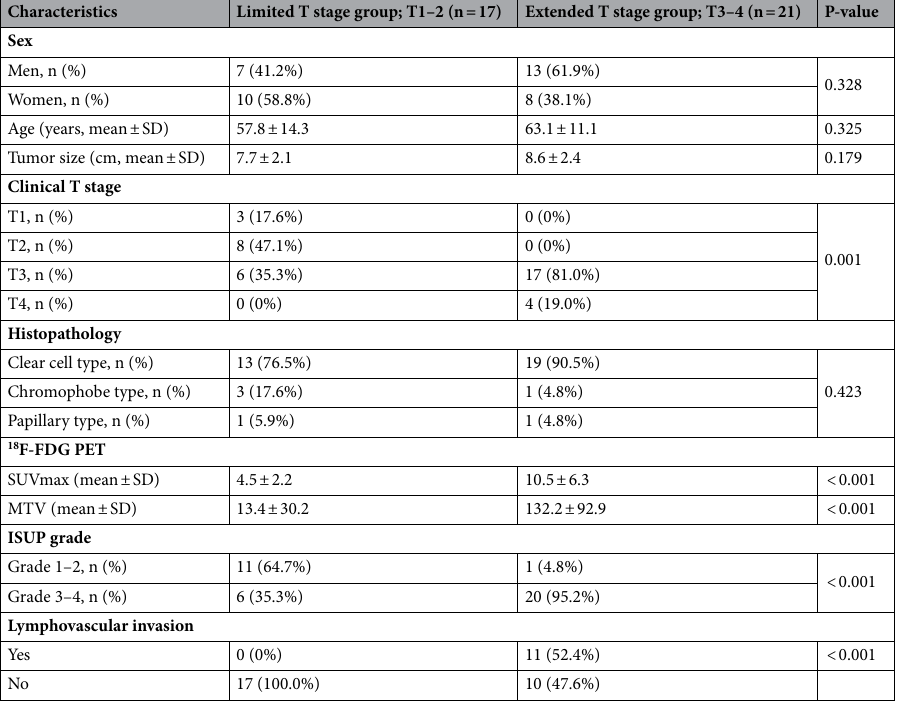
Table 1. Patient clinical